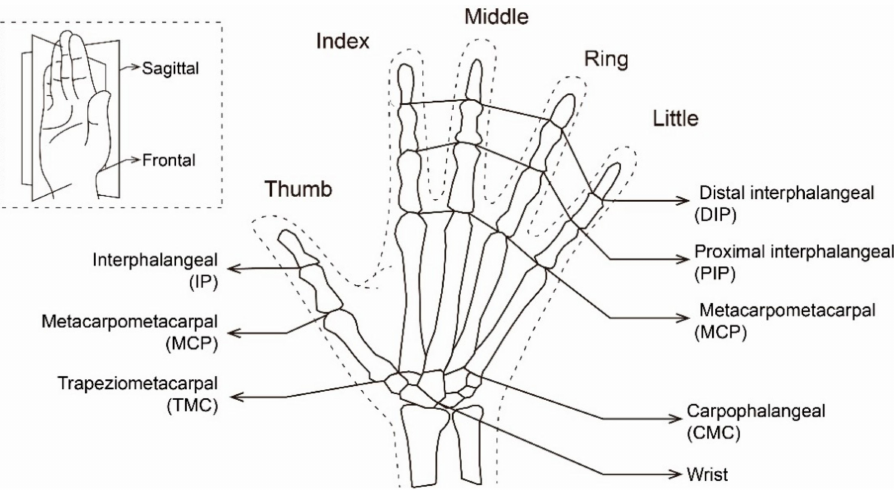
Figure 1. Structure and naming method of hand skeleton.